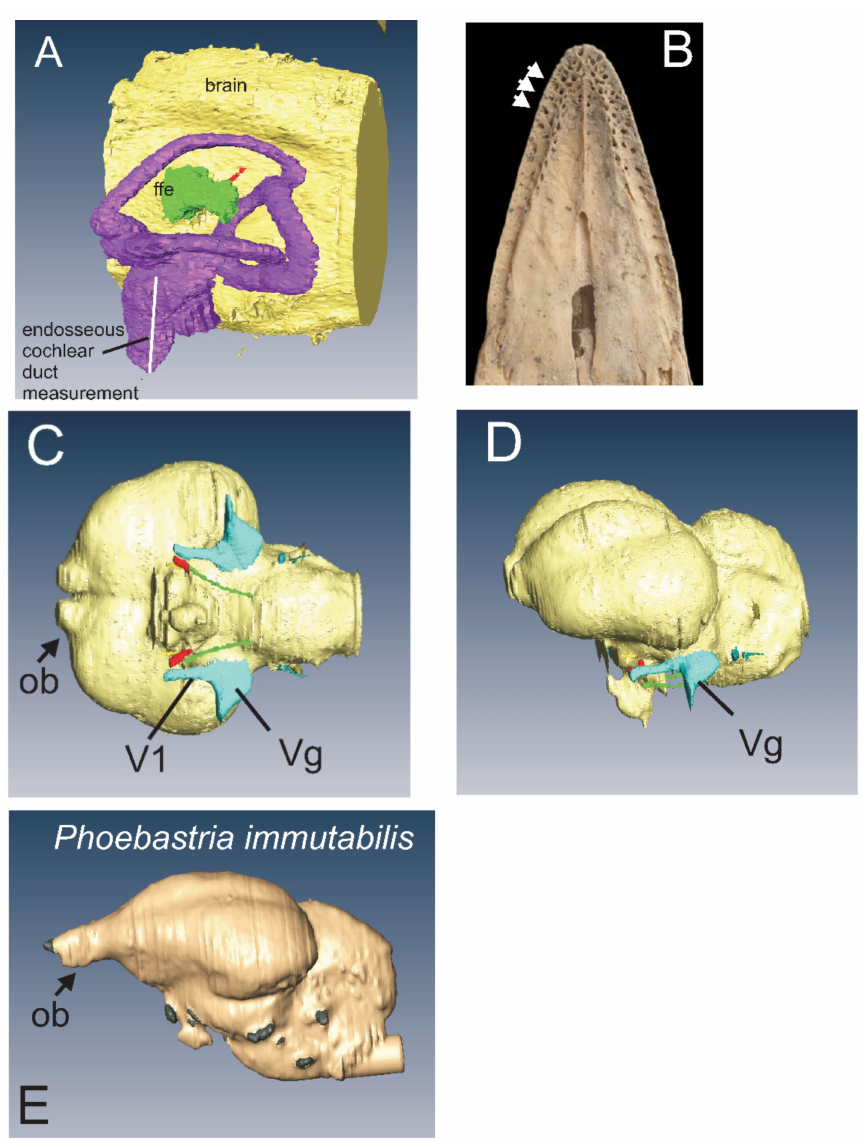
Figure 10. ( A ) Megalapteryx didinus left otic labyrinth and adjacent structures. ffe, floccular fossa endocast ( B ) M. didinus , bill pits in oral view, photo courtesy of Trevor Worthy ( C , D ) M. didinus , brain reconstruction in ( C ) ventral and ( D ) left lateral views.ob, olfactory bulb, V1, ophthalmic division trigeminal nerve; Vg, trigeminal ganglion ( E ) An albatross with a well-developed olfactory